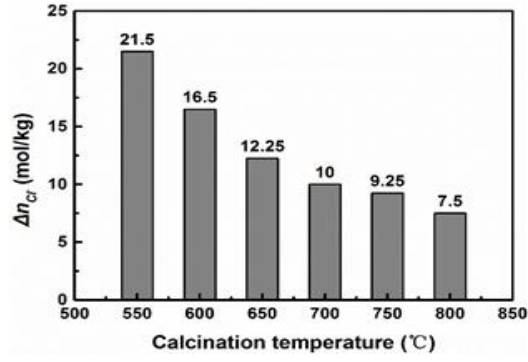
Figure 1. Experimental result Δn Cl− of different active magnesium oxide.